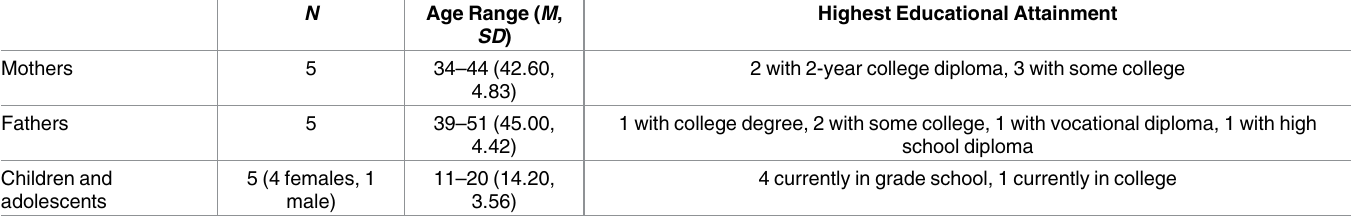
Table 1. Demographic information about resilient